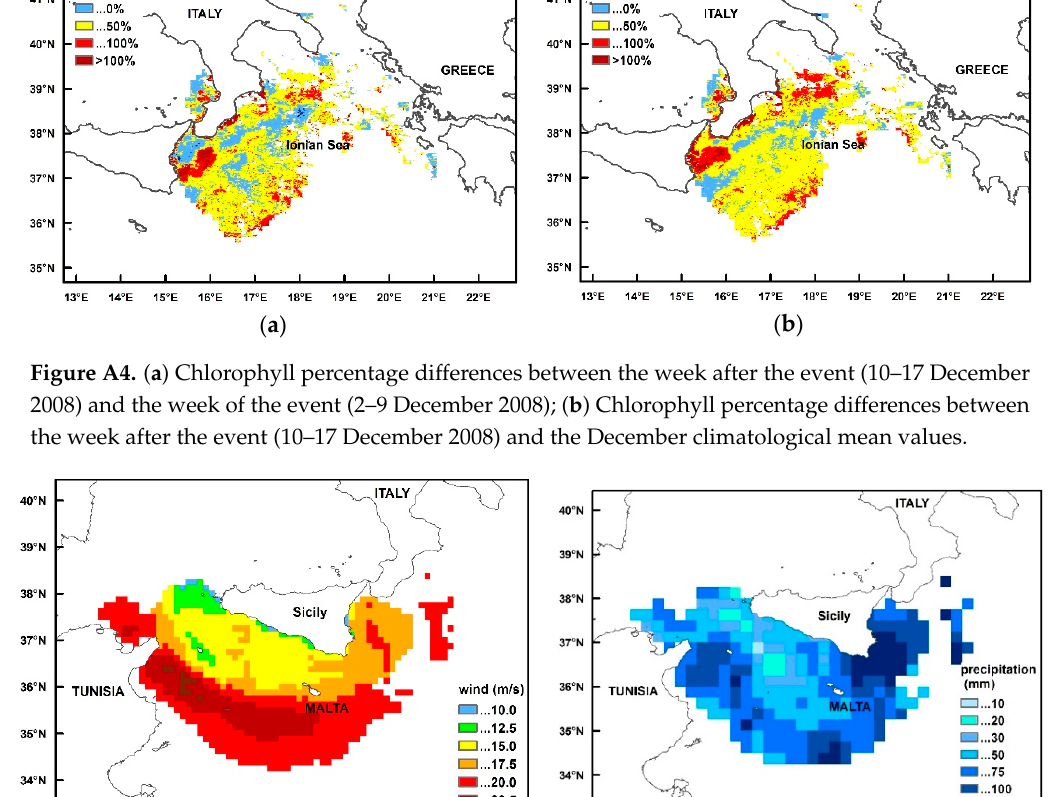
Figure A5. ( a ) Maximum 10 m wind speed during the medicane of 7–8 November 2014; ( b ) Precipitation